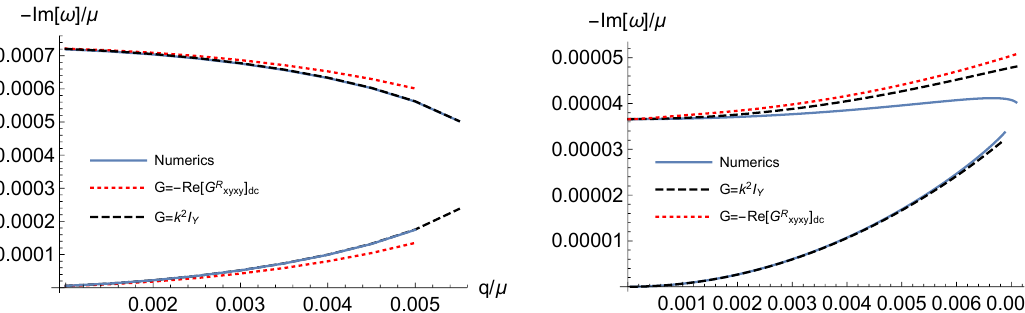
Figure 5 . Comparison between the exact numerical dispersion relation of the two longest-lived transverse QNMs and the hydrodynamic prediction (3.6) for the dispersion relation, using for the Goldstone shear modulus the correct prescription (3.15) or the wrong one (3.13). In the right panel, the wrong prescription predicts that the gapless mode is in the upper half plane (not displayed). Left: ‘=(cid:22) = 0 : 01, T=(cid:22) = 0 : 1, k=(cid:22) = 0 : 1. Right: ‘=(cid:22) = 0 : 003, T=(cid:22) = 0 : 1, k=(cid:22) = 0 : 001.